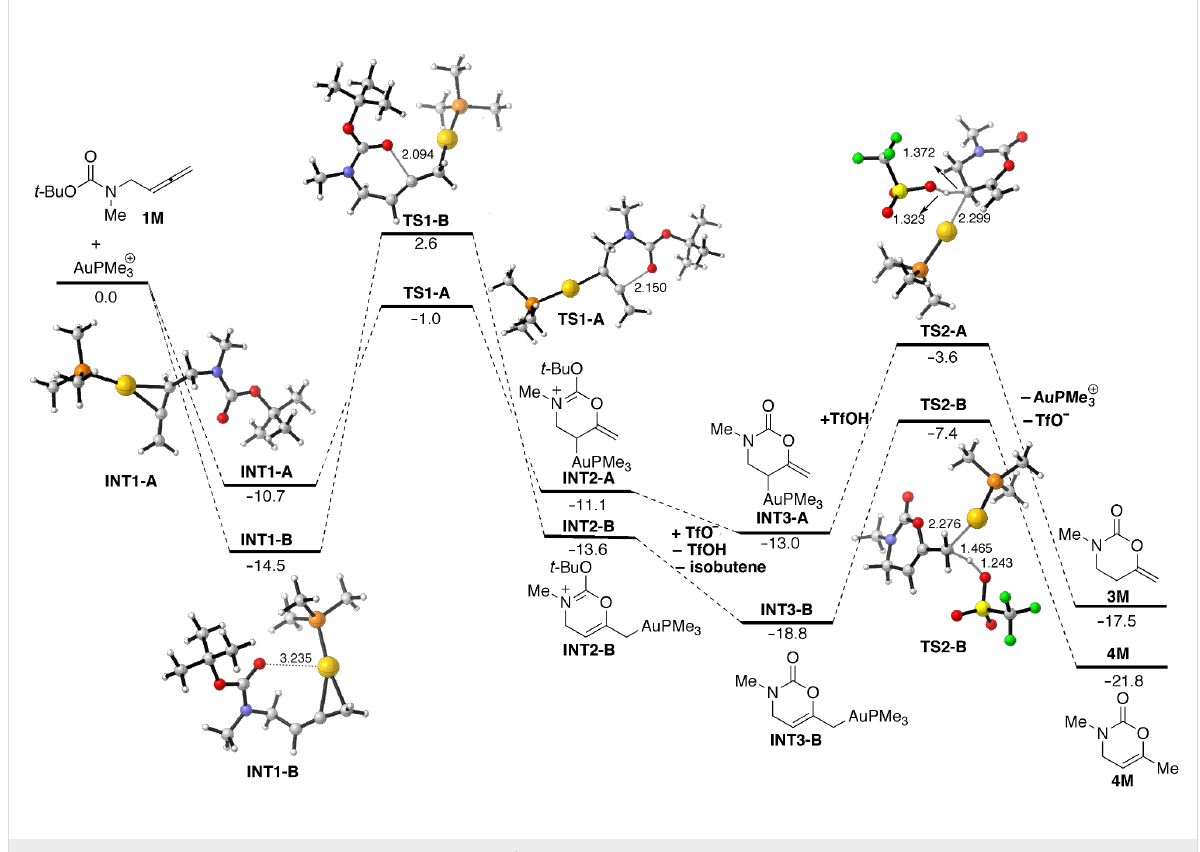
Figure 1: Computed reaction profile for the reaction of AuPMe 3+ and 1M . Numbers indicate the corresponding PCM-corrected Δ G 298 energies (in kcal/mol) using dichloromethane as solvent. Bond distances are given in angstroms. All data have been computed at the PCM-M06/def2-SVP// B3LYP/def2-SVP